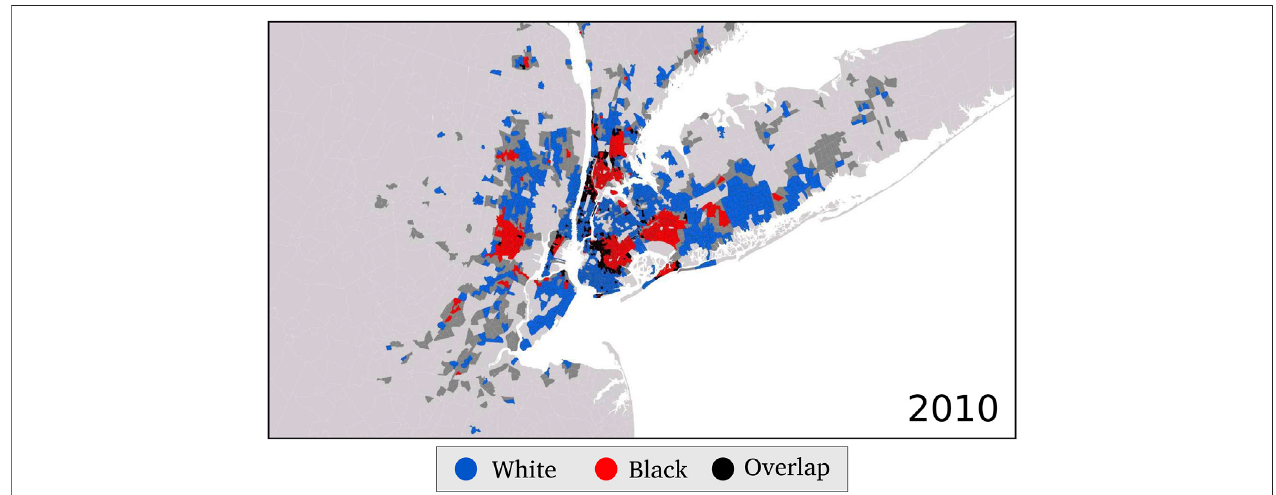
FIGURE 2 | HD zone for white and black. We show the HD zone for white (blue) and black (red) citizens with the respective Overlap zone (black) in the year 2010. Dark grey tracts are part of the city that does not belong to any zone, while light grey tracts are not part of New York City.